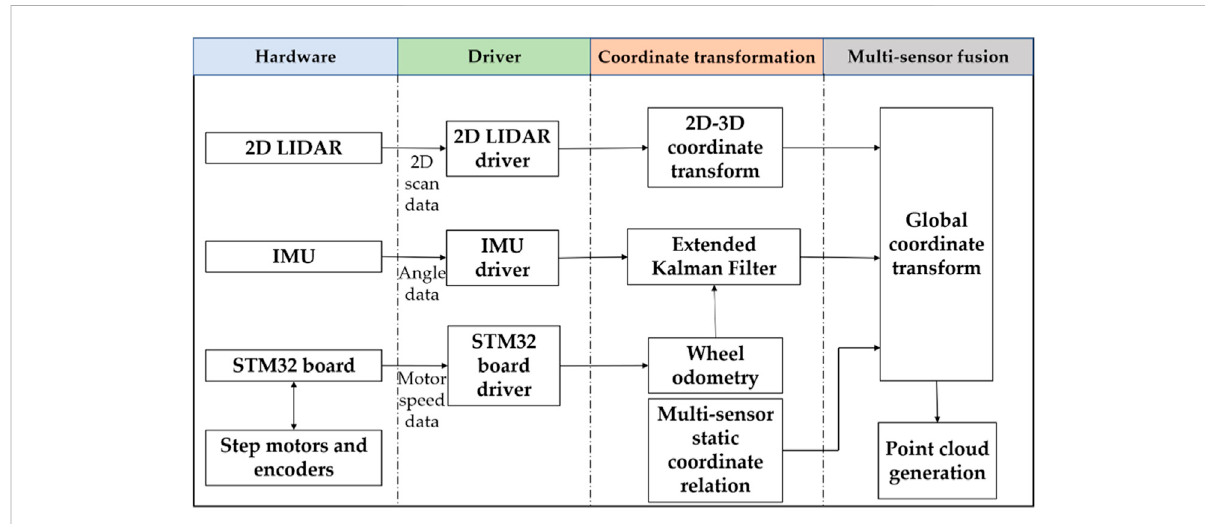
FIGURE 3 Software architecture of the 3D imaging system.